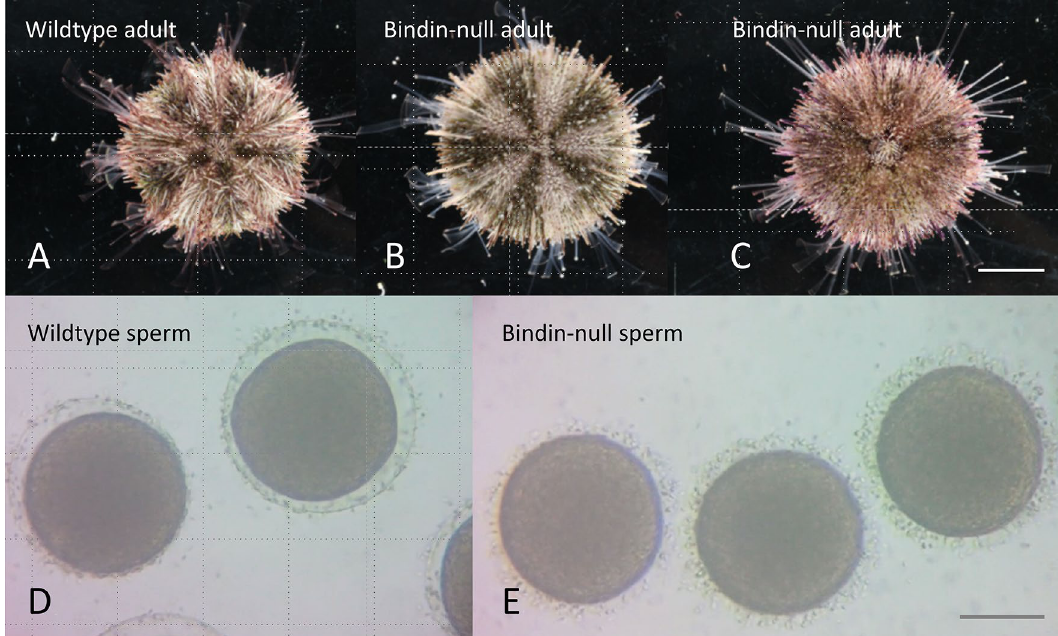
Figure 1. A wildtype adult H. pulcherrimus seen from the dorsal (aboral) surface ( A ). Bindin-null adults ( B and C ) are indistinguishable from the wildtype adults, and throughout their developmental progression to this point (not shown). Wildtype sperm activate eggs within moments of exposure, resulting in formation of the fertilization envelop ( D ). In contrast, Bindin-null sperm never activate an egg, even after prolonged exposure ( E ). See also Video S1 in the Supplemental Material. Scale bar in C = 1 cm for A – C ; Scale bar in E = 40 µm for D and E